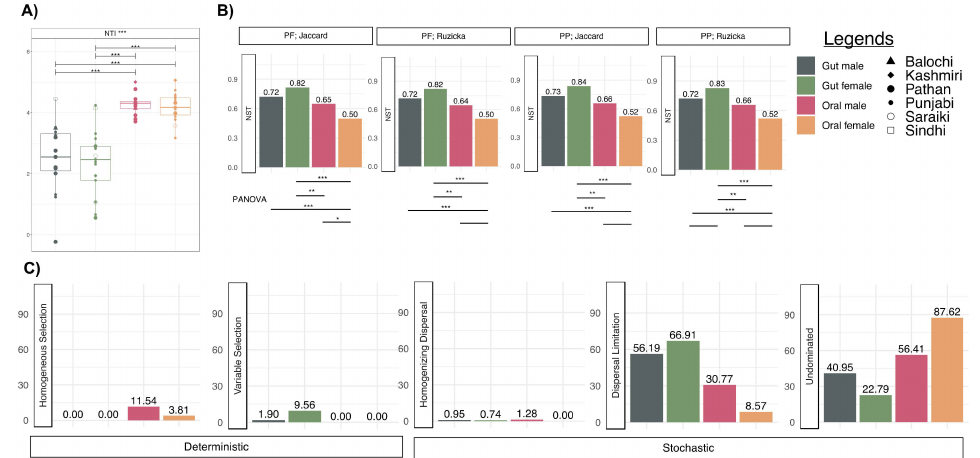
Figure 6. Estimates of microbial community assembly mechanisms structuring samples from four different cohorts (gut male, gut female, oral male, and oral female). ( A ) phylogenetic alpha diversity measure, nearest taxon index (NTI) to elucidate environmental pressures (signficances are calcu- lated with ANOVA). ( B ) Normalised stochasticity ratio (NST) calculated as both incidence based (presence/absence) Jaccard and abundance based Ruzicka metrics with PF and PP being the null modelling regime used. PANOVA connects pairwise categories where the estimates are statistically significant in terms of NST; ( C ) Proportion of assembly processes returned from applying quantitative processing estimate (QPE) for all four cohorts presented as both deterministic and stochastic measures. Lines connecting categories shows significant relationships: blank p < 0.1, * p < 0.05, ** p < 0.01), or *** p <